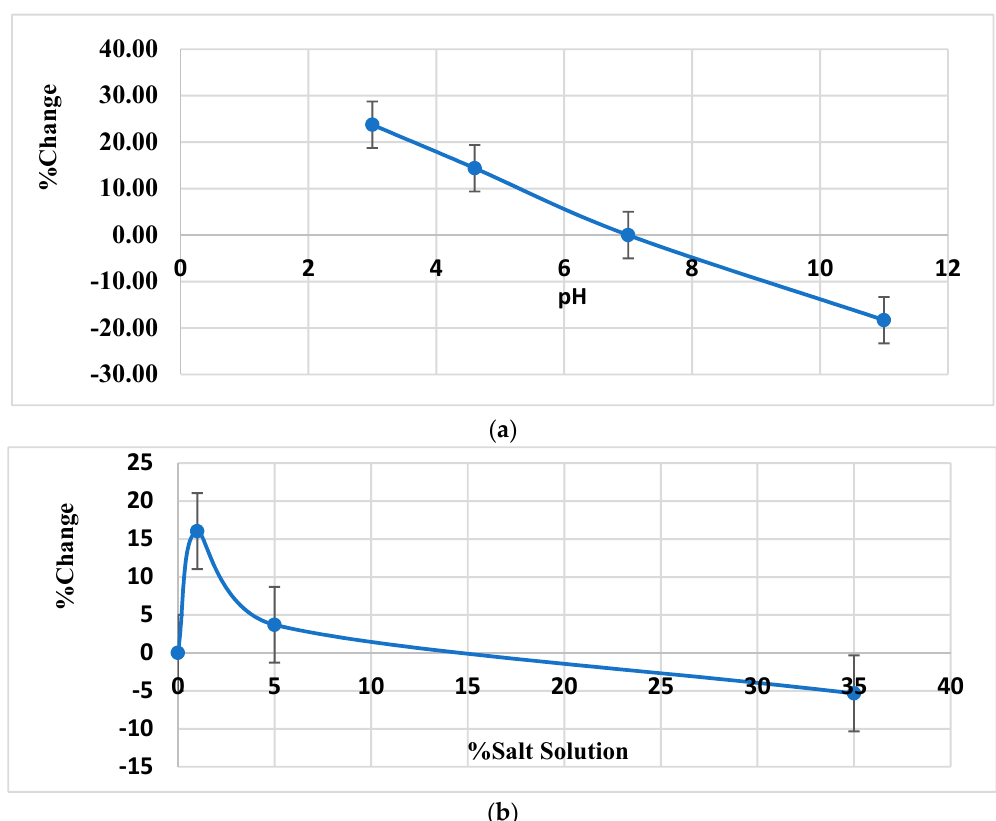
Figure 4. ( a ) percent change to the normalized area under the curve as compared to pH 7, ( b ) percent change to the normalized area under the curve as compared to distilled deionized water (0% salt solution).